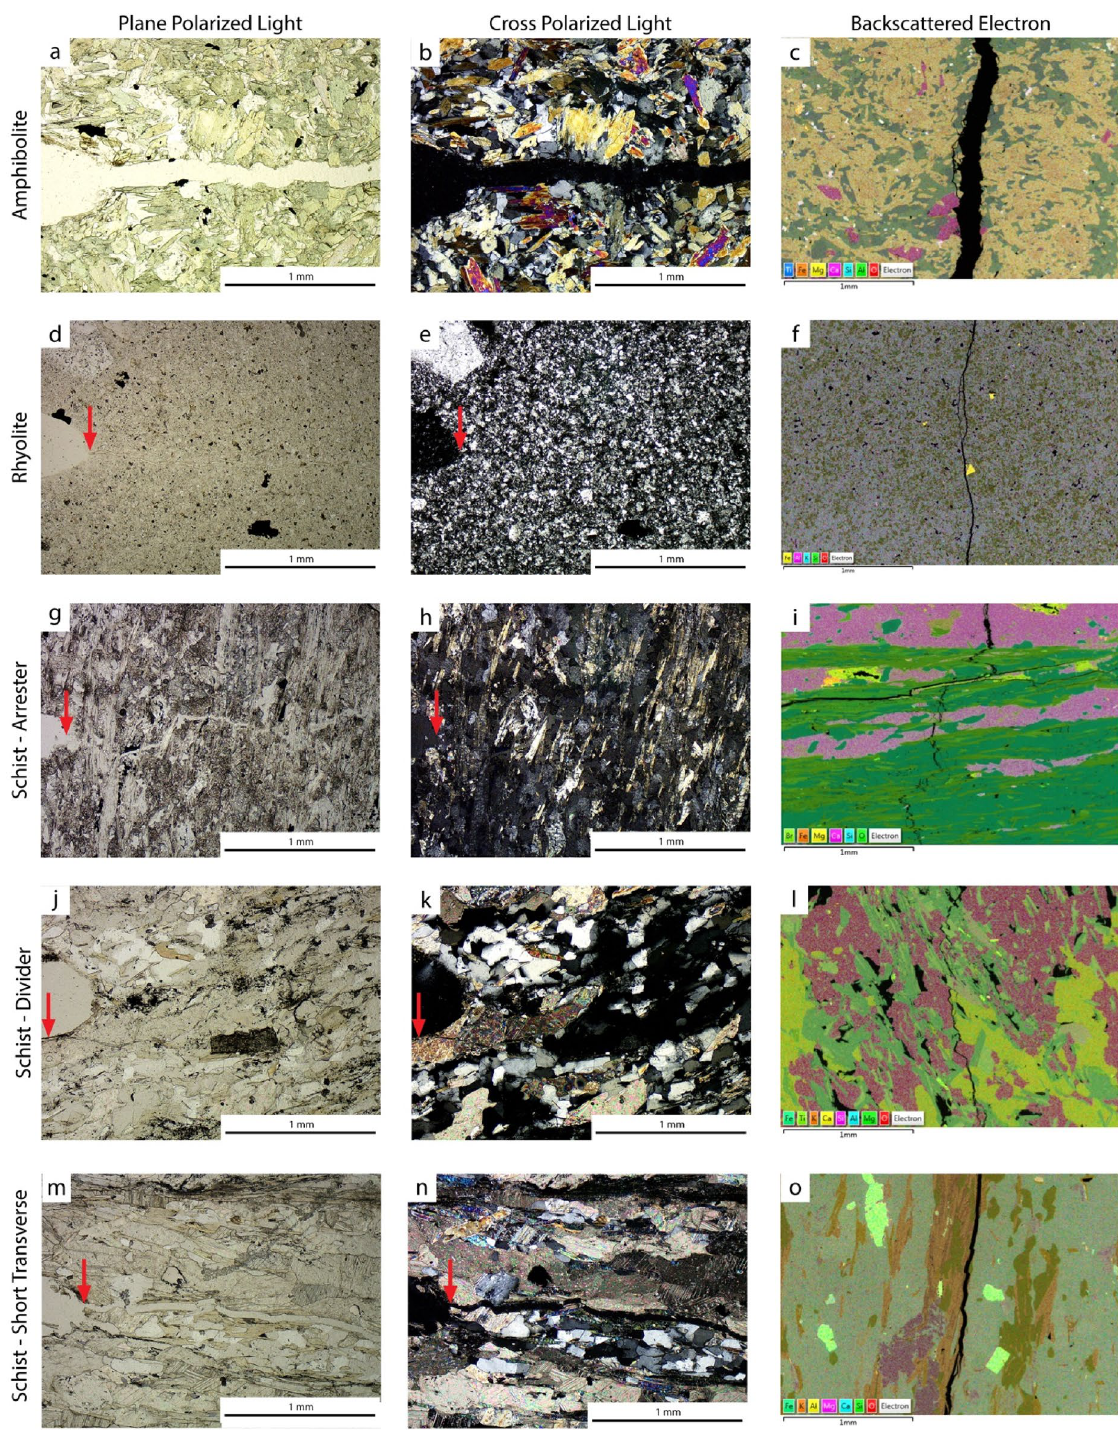
Figure 6. Thin section images, from an optical microscope under plane-polarized and cross-polarized light, and a BSE-EDS stacked image from a scanning electron microscope for each sample group. Arrows indicate the location of fracture